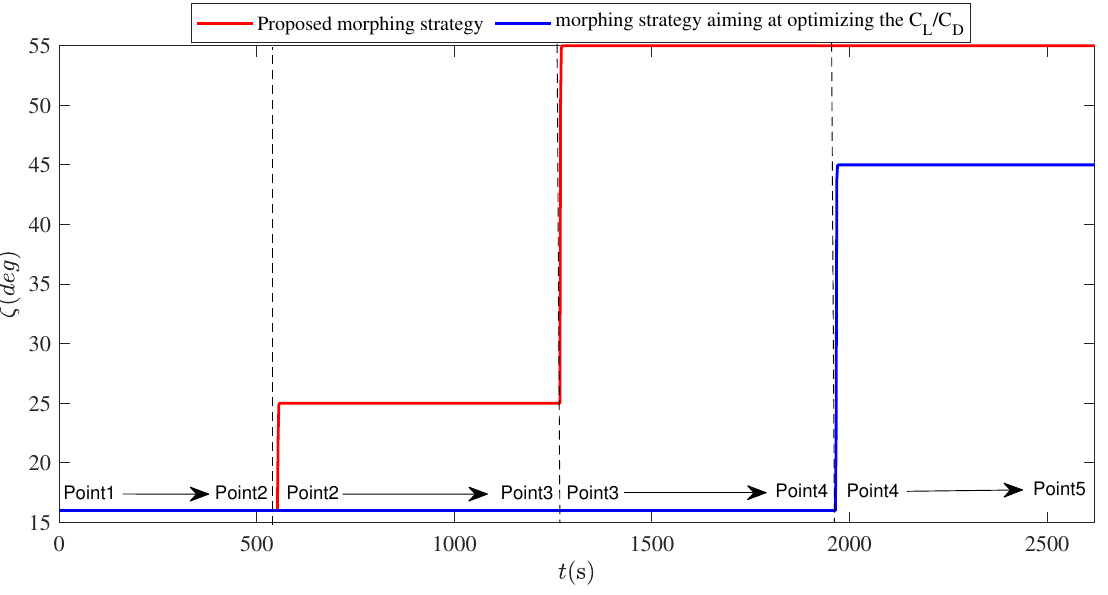
Figure 18. ζ of the comparative simulation in Section